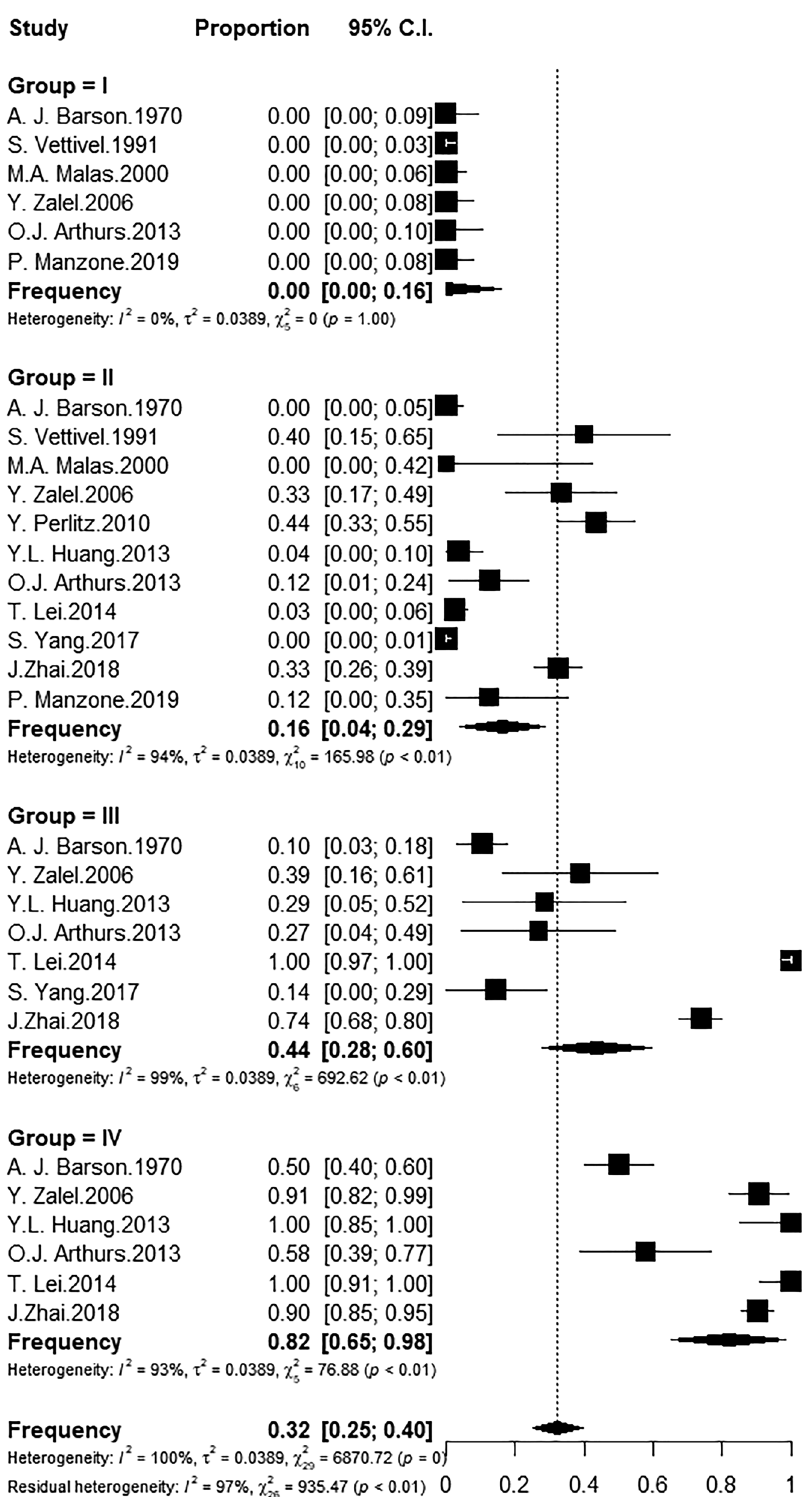
Figure 3. Frequency of foetuses with CM at L2 or above by gestational age